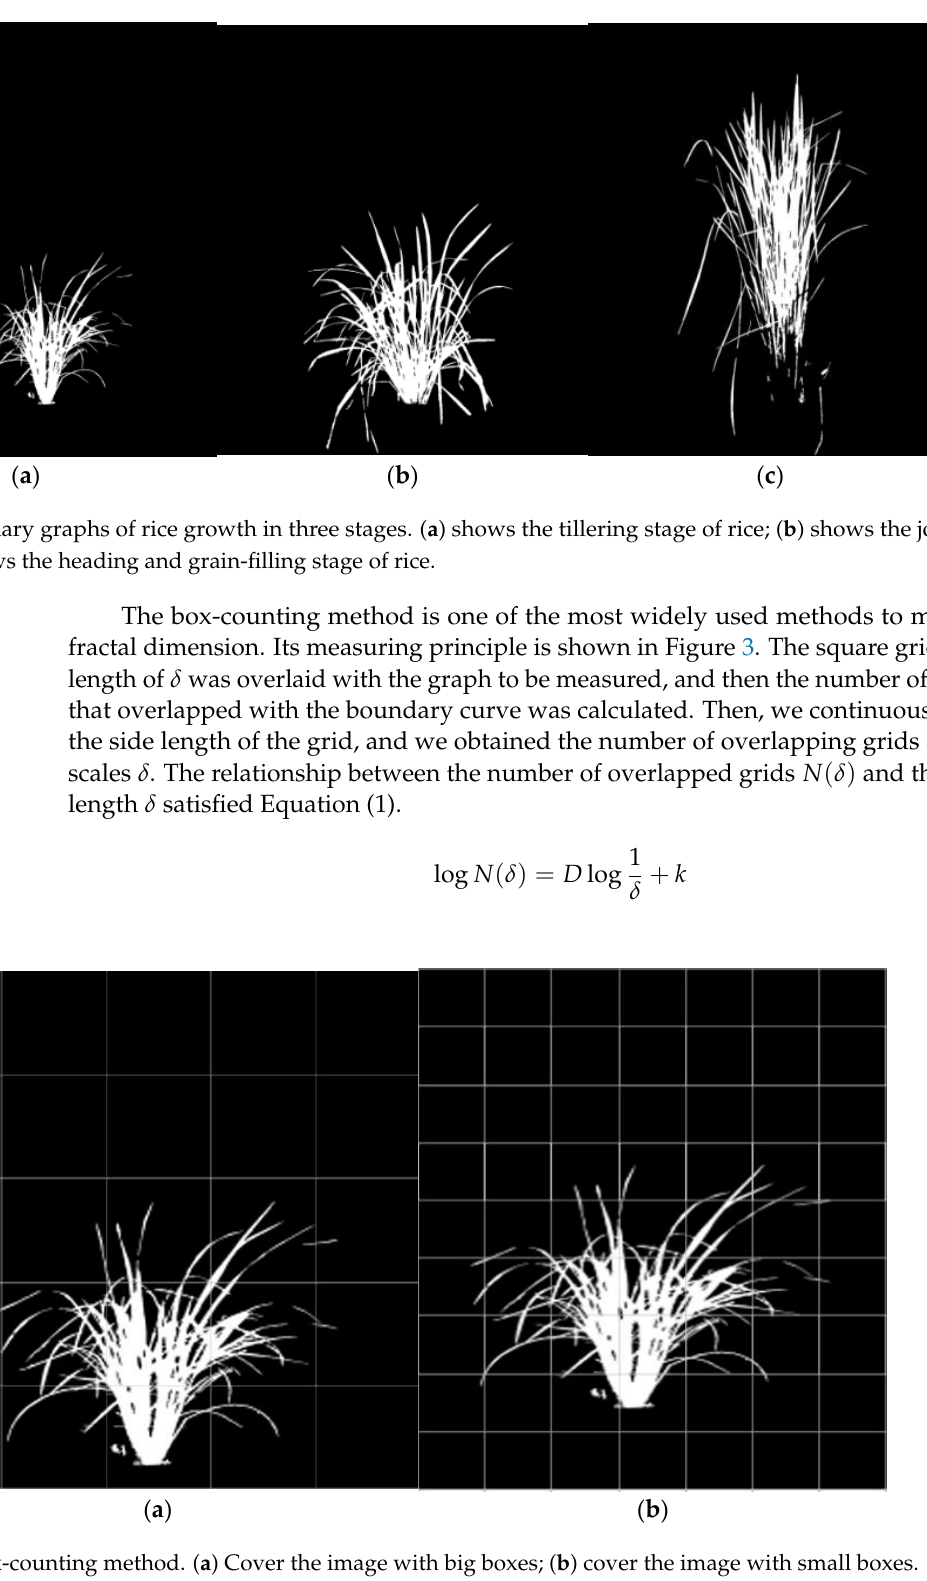
Figure 3. Box-counting method. ( a ) Cover the image with big boxes; ( b ) cover the image with small boxes.